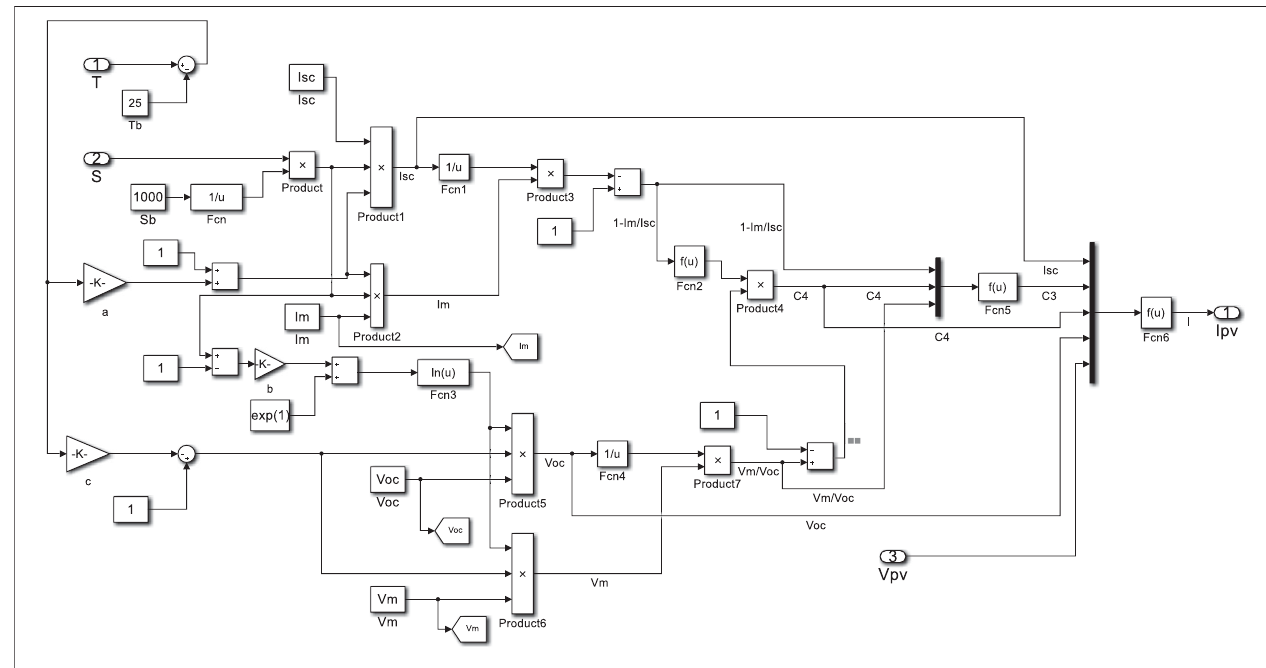
FIGURE 2 | PV cells internal structure simulation diagram.